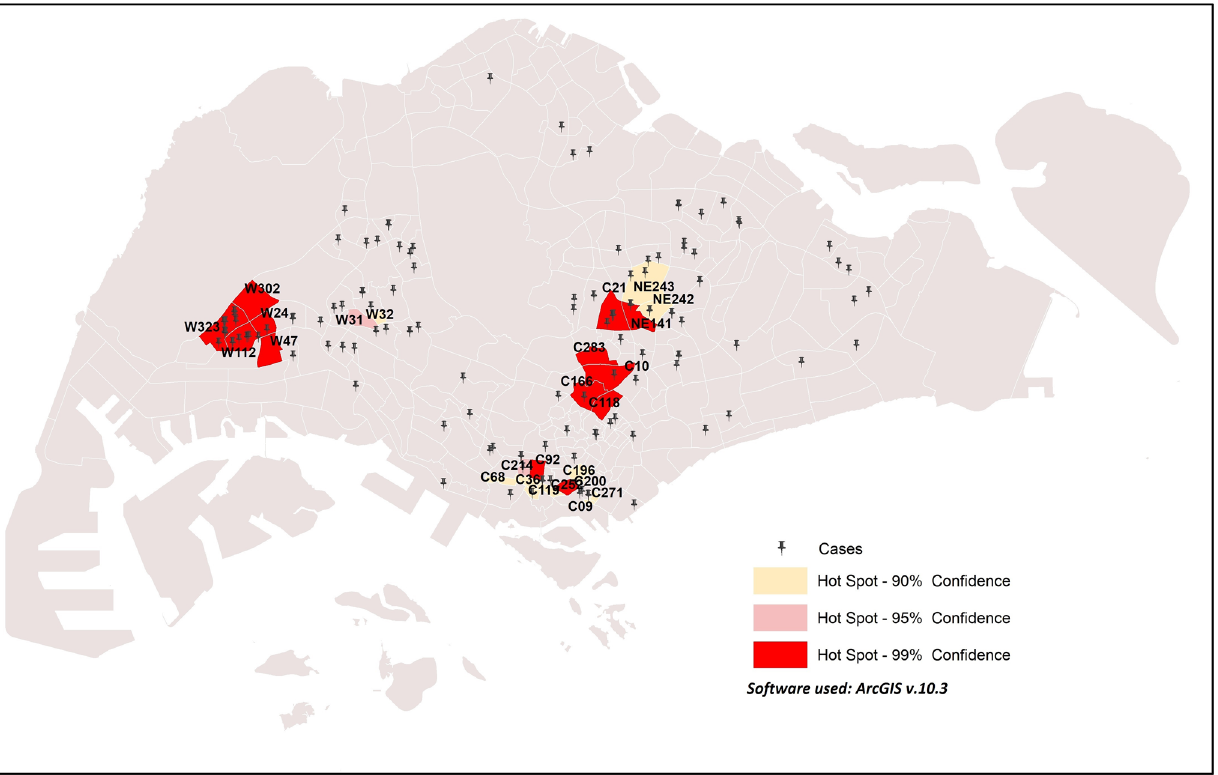
Figure 1. COVID-19 hotspot clustering across Singapore in the early phase of COVID-19